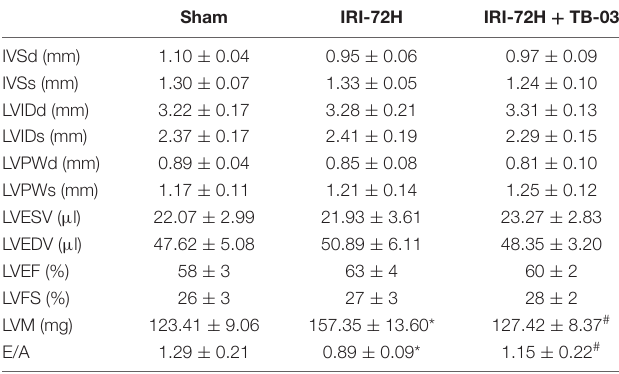
TABLE 2 | Echocardiography after renal ischemia–reperfusion injury. Sham